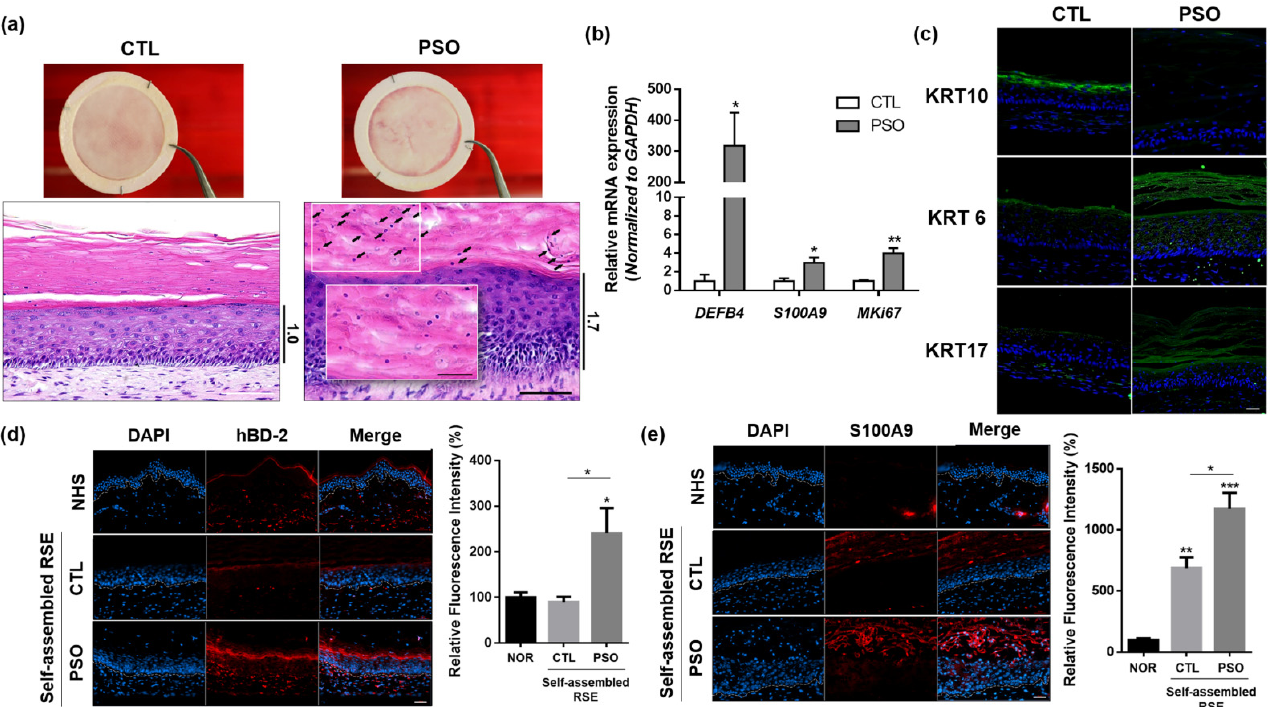
Figure 4. Psoriatic phenotypes of the IL-17A-induced self-assembled RSE models. ( a ) histological analysis of self-assembled psoriasis RSE model (Bar = 100 µm, n = 4). The arrows indicate remaining nuclei in the stratum corneum. ( b ) The mRNA expression of DEFB4, S100A9, and MKi67 in the self- assembled RSE model was analyzed by RT-qPCR. ( c ) Immunofluorescence staining analysis of KRT6, KRT10, and KRT17 in self-assembled psoriasis RSE model (Bar = 50 µm, n = 4). ( d ) Immuno- fluorescence staining of HBD-2 in normal human skin and self-assembled RSE (Bar = 50 µm, n = 4). For quantification, the fluorescence intensity of the red signals was examined by Image J. ( e ) Immu- nofluorescence staining of HBD-2 in normal human skin and self-assembled RSE (Bar = 50 µm, n = 4). For quantification, the fluorescence intensity of the red signals was examined by Image J. The self-assembled RSE models were treated with vehicle (D.W) for control or 100 ng/mL of IL-17A for the psoriatic model is treated to the culture medium. RSE: Reconstructed skin equivalent; NHS: Normal human skin; PSO: Psoriatic RSE. * p < 0.05; ** p < 0.01; *** p < 0.005. 4. Discussion Since the OECD first specified guidelines for predicting the skin irritation potential of medical devices in the 1980s (ISO 10993), additional guidelines, including skin cytotox- icity and hypersensitivity testing methods, were later created [4,10]. Since 2010, the testing guidelines 439 (TG439) have been implemented by several institutes and companies for assessing in vitro test methods for predicting skin irritation potential [7]. In the past, skin irritation and sensitivity tests have been conducted using rabbits or guinea pigs. However, since this causes great discomfort or pain in the animals and there are significant differ- ences in the skin toxicity induced by chemicals depending on the species, in vitro skin irritation test methods have been developed [26]. From this point of view, we verified our self-assembled RSE according to the OECD guidelines and confirmed the disease-model- ing potential of this RSE. A self-assembled RSE model was developed to simulate the full-thickness human skin without the use of exogenous materials, such as murine-, porcine- or bovine-derived ECM [18,19]. The ECM of the self-assembled RSE is composed of human fibroblast-se- creted ECM molecules and thus it can be an ideal model for mimicking native skin [27,28]. Our observations revealed that the self-assembled RSE had similar structure and mor- phology to those of the normal human skin, as assessed using immunohistochemical